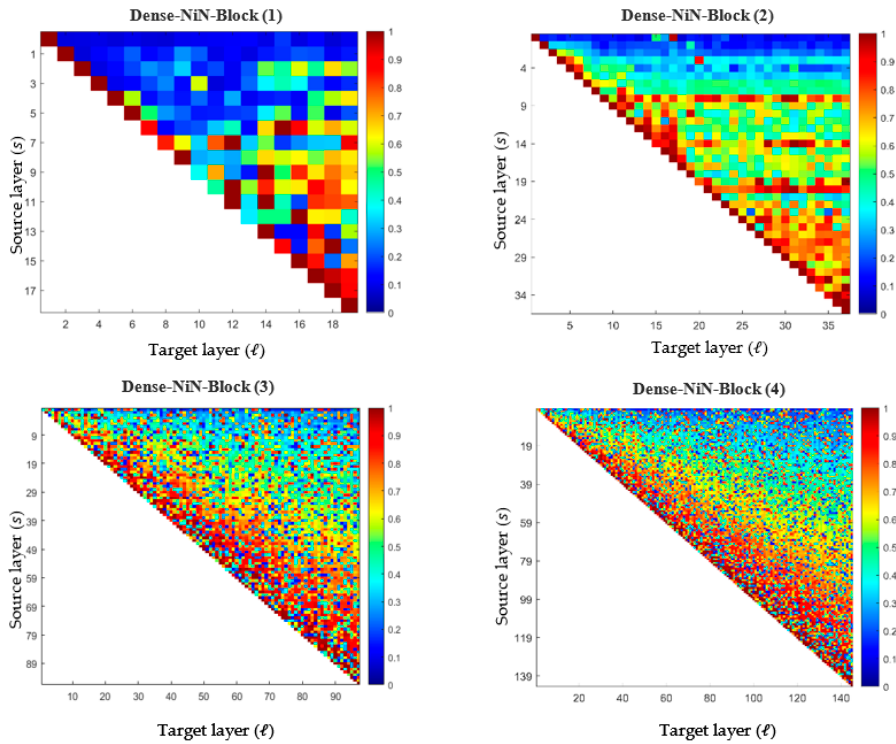
Figure 13. Visualization effect charts. The average absolute filter weights of the convolutional layers in a trained DenseNet201. The color of the pixel at ( 𝑠 , ℓ ) encodes the average 𝐿1 norm (normalized by the number of input feature maps) of the weights connecting convolutional layer 𝑠 to ℓ within a dense block. The three columns highlighted by black rectangles correspond to two transition layers and the classification layer. The first row encodes the weights connected to the input layer of the dense block.